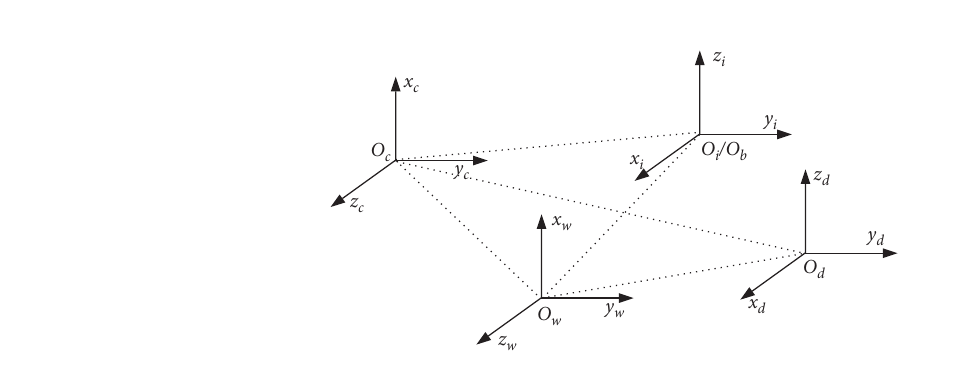
Figure 2: The overall coordinate